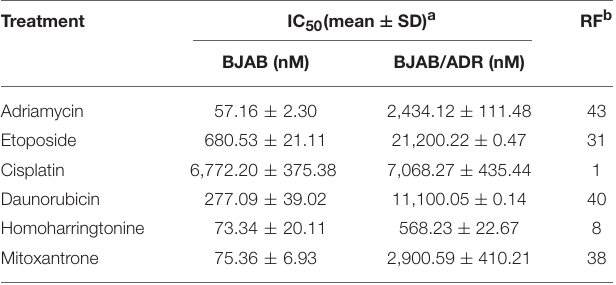
TABLE 1 | Cell cycle distribution of BJAB and BJAB/ADR cells. TABLE 2 | Cross-resistance profile of BJAB/ADR cells to other anticancer